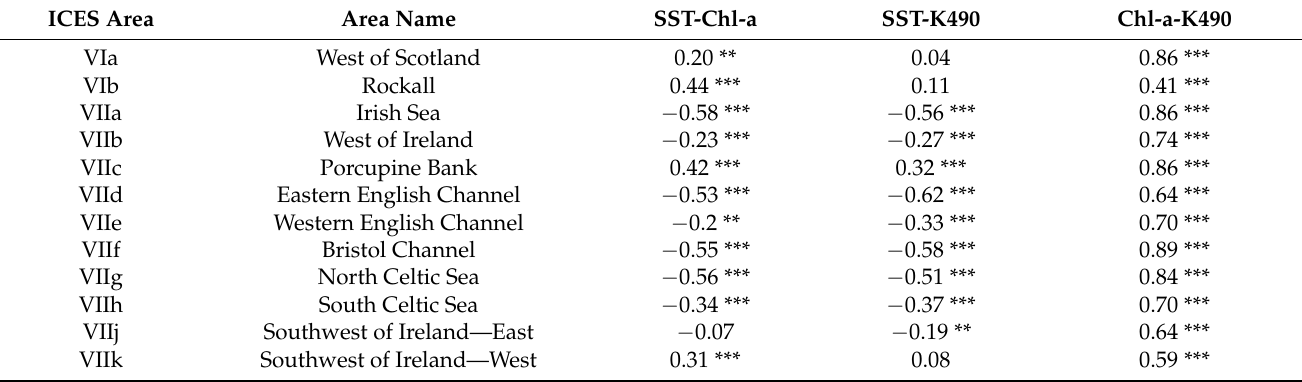
Table 1. Pearson correlation coefficients for each pair of variables in each ICES division. Significance